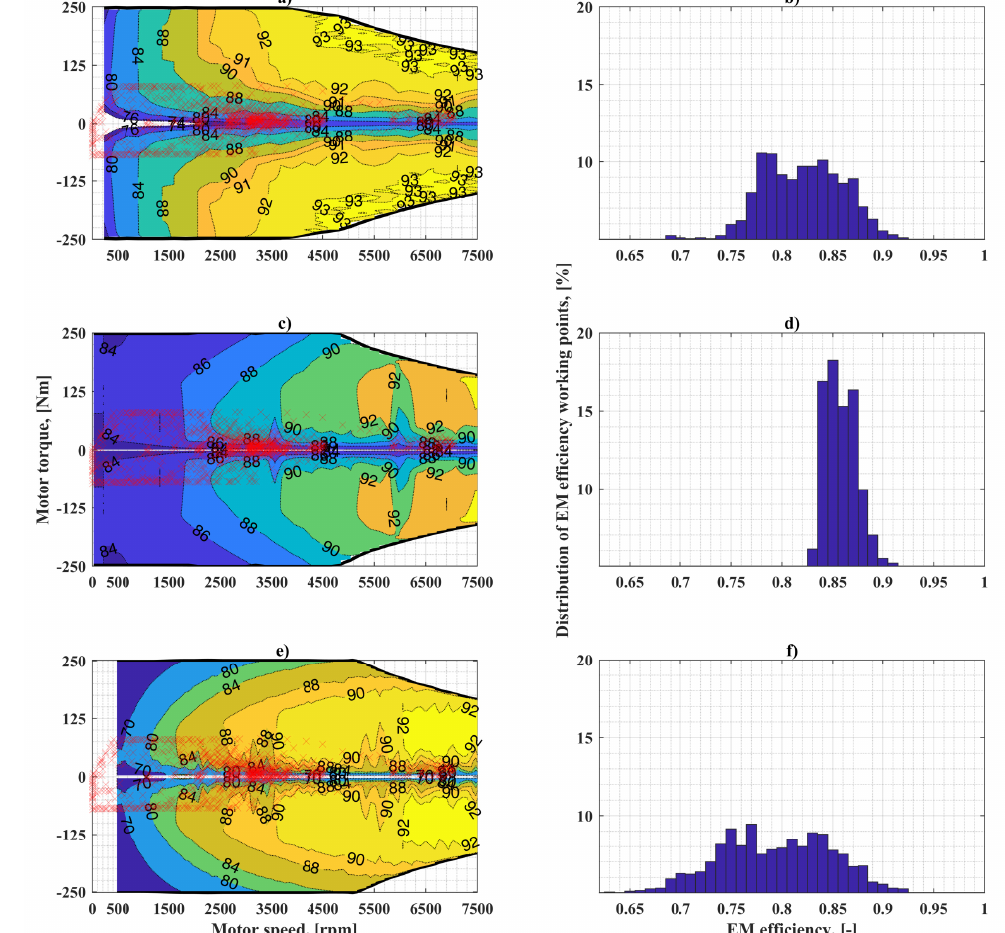
Figure 6. Working points on the UDDS cycle with different EMs installed on BMW i3 BEV. Character- istics of EMs re-scaled to BMW i3 maximum power point ( right column) and distribution of their efficiency working points ( left column) for: BMW i3 EM ( a , b ); Kia Soul EM ( c , d ); YASA EM ( e , f